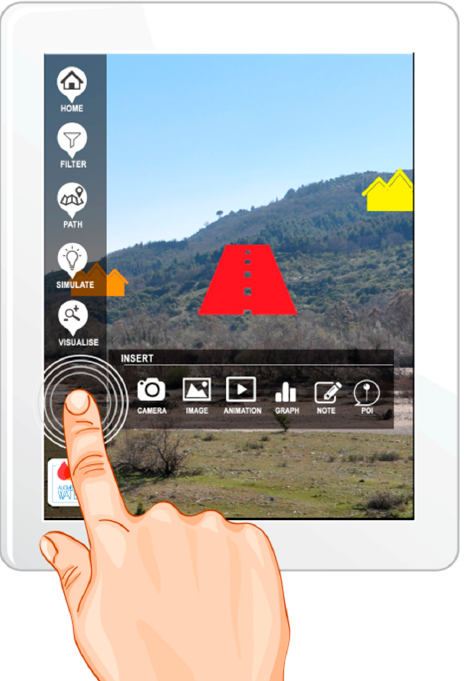
Figure 2. Application billboards associated with some points of interest (POIs).